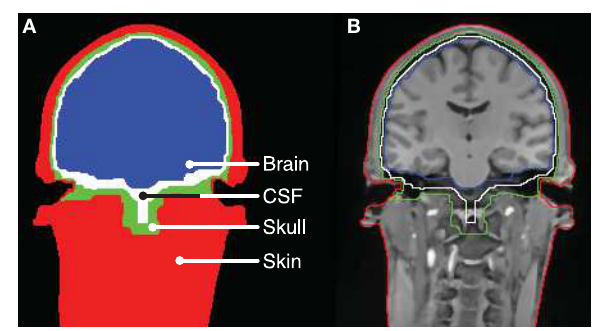
FIGURE 2 | Tissue boundaries for a slice of the head model for Subject C. (A) Tissue segments. (B) MRI scan with indication of the tissue boundaries.